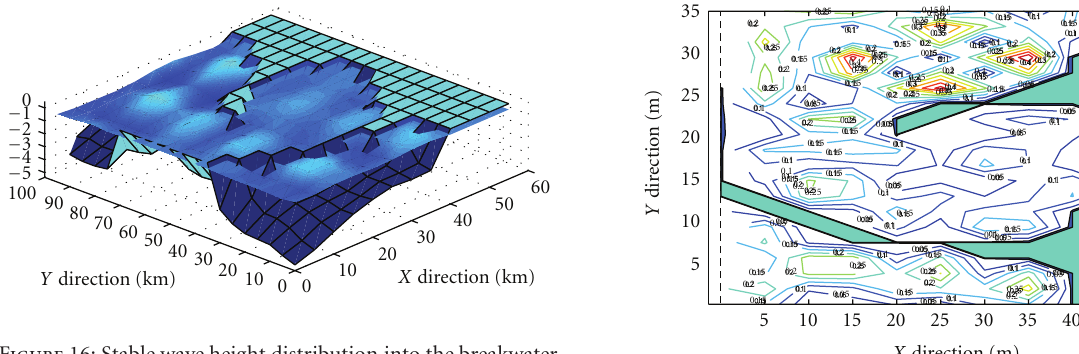
Figure 16: Stable wave height distribution into the breakwater.